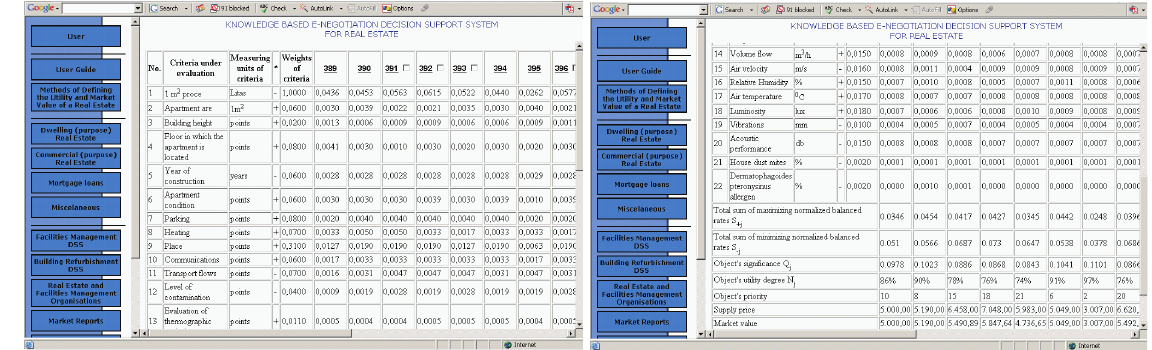
Figure 2. results of multiple criteria evaluation of 3-room apartment’s alternatives: upper part of matrix for obtained results (left ); lower part of matrix for obtained results ( right )